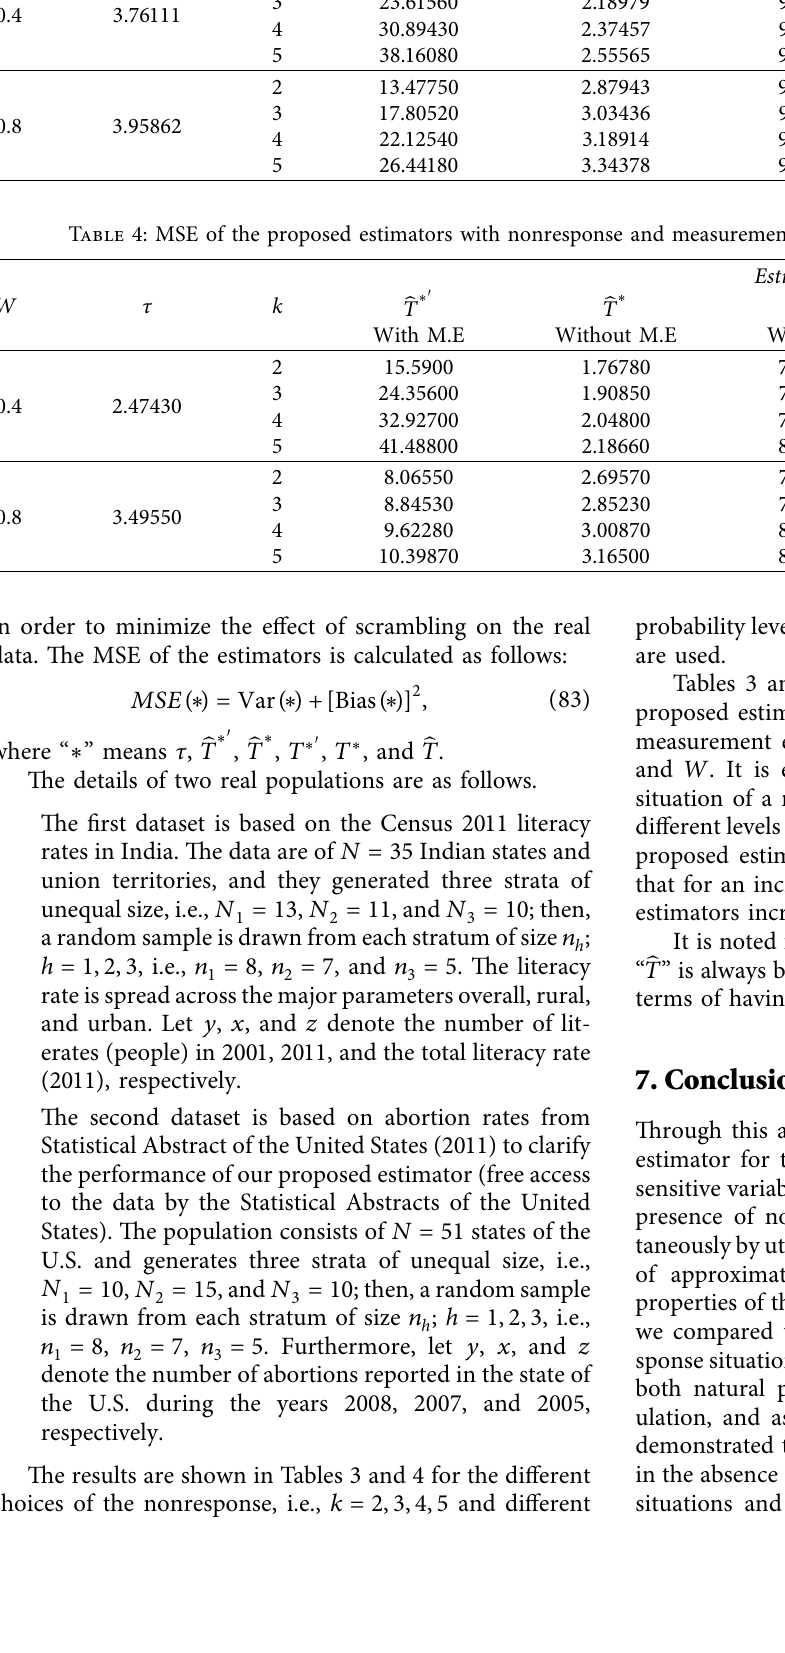
Table 3: MSE of the proposed estimators with nonresponse and measurement errors for diferent values of k and W . W τ k 0.4